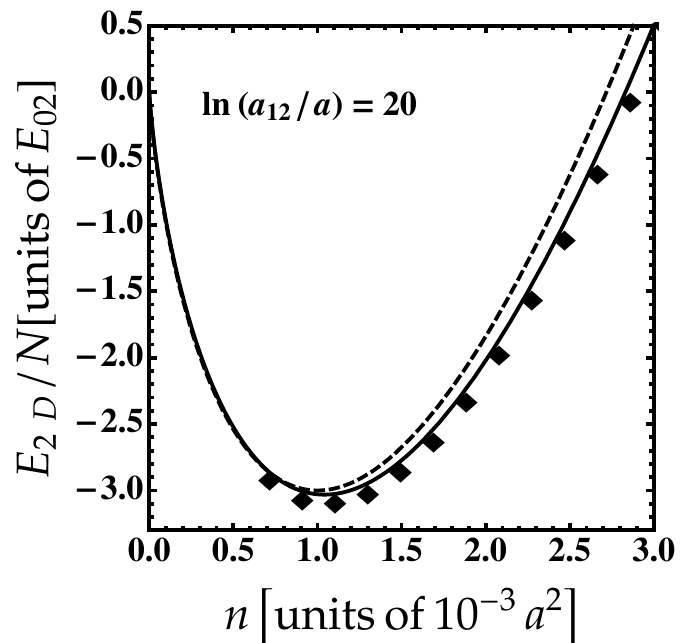
Figure 4. Two-dimensional ground-state energy as a function of the density for ln ( a 12 / a ) = 20. Solid lines correspond to our beyond-LHY results up to third order in ˜ n and ˜ m . Dashed line corresponds to the Bogoliubov theory [21]. Black squares correspond to DMC data [21]. Here, E 02 = 4¯ h 2 / ( e 2 γ ma 2